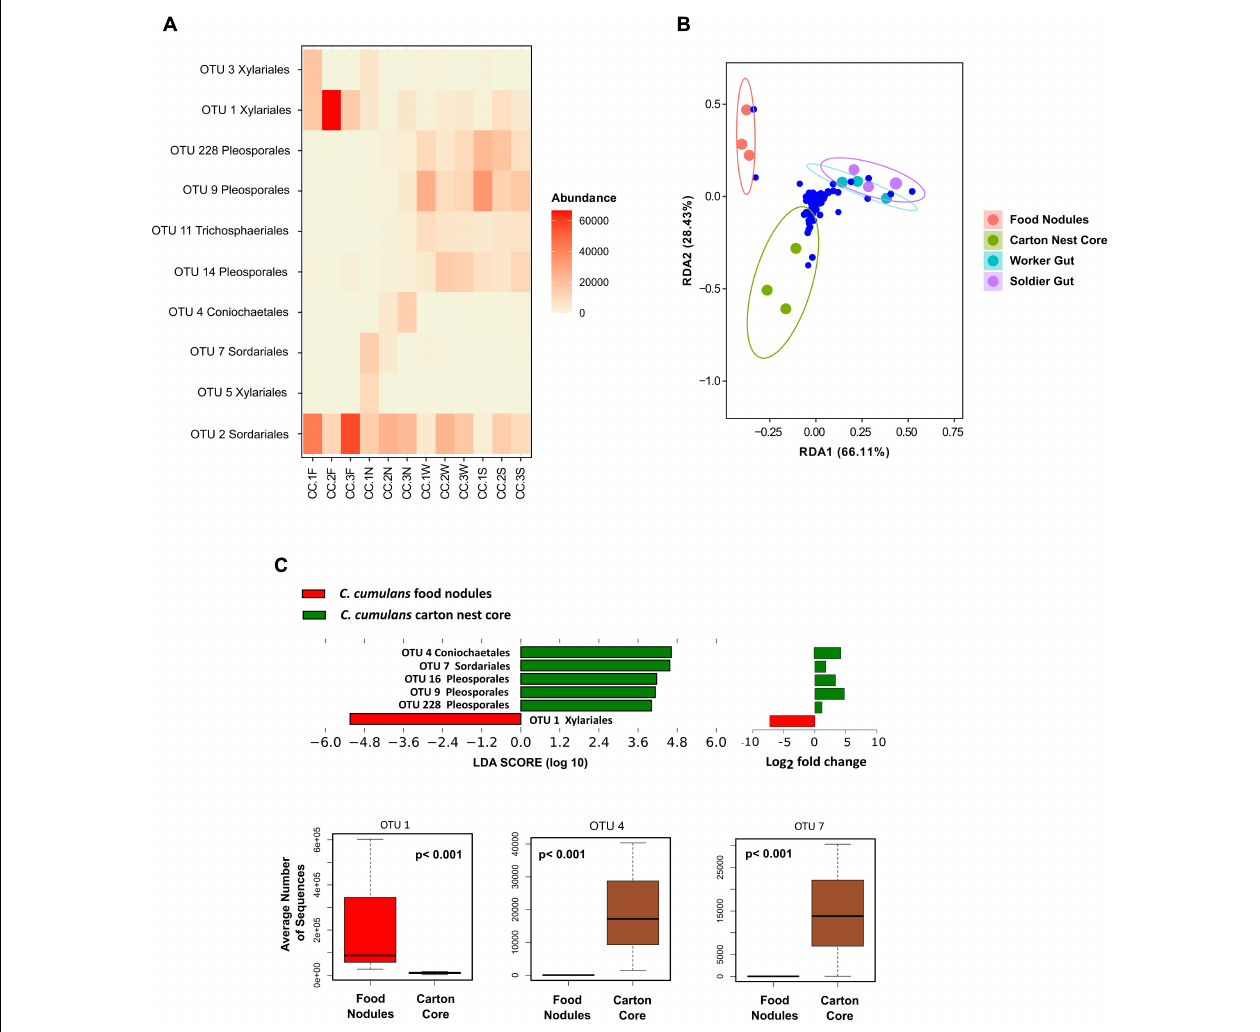
FIGURE 2 | (A) Comparison of the relative abundances ( > 1%) of fungal OTUs of C. cumulans. (B) Ordination plots showing fungal communities of gut and nest samples after redundancy analysis of Hellinger transformed abundance of OTUs (blue dots) with colony number (colored circles) as conditional variable. RDA1 Nest Substrates; variance = 0.140, p -value = 0.001, and RDA1 Termite Gut; variance = 0.06, p -value = 0.002, permutations tests ( n = 999). (C) Linear discriminant analysis (LDA) combined with effect size measurements (LEfSe, score > 4) and DESeq2 ( p ≤ 0.05) analyses to identify the fungal OTUs responsible for the differences between nest substrates. Boxplots report median, upper and lower quartiles, and maximum and minimum values of the relative abundance of taxa identified by both DESeq2 and LEfSe analyses. A p -value < 0.05 was considered significant in GLMM analyses. See Figure 1 for samples